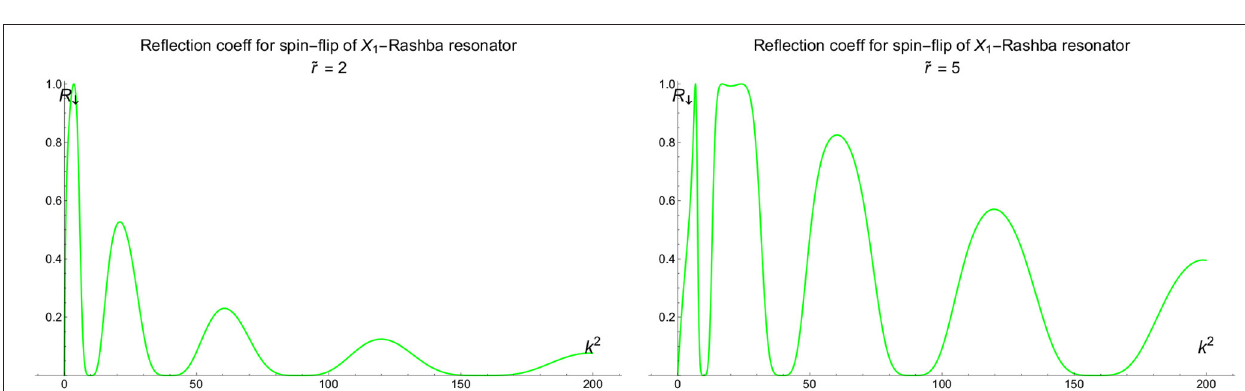
r X 1 resonator (see Figure 2 ) at different values of state for ˜ ↓ −